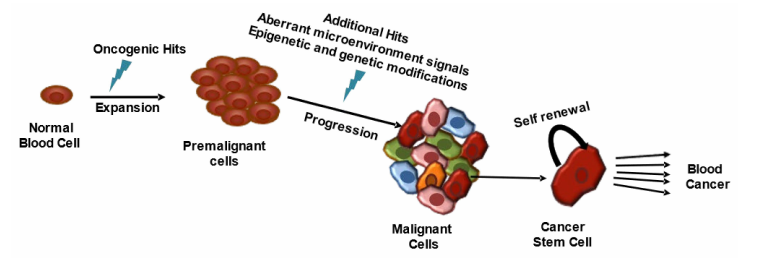
Figure 3. Molecular mechanism of hematological malignancies. Oncogenic hits in a normal blood cell produce premalignant cells. Additional oncogenic hits promote the development of malignant cells. Among the malignant cells, cancer stem cells have self-renewal